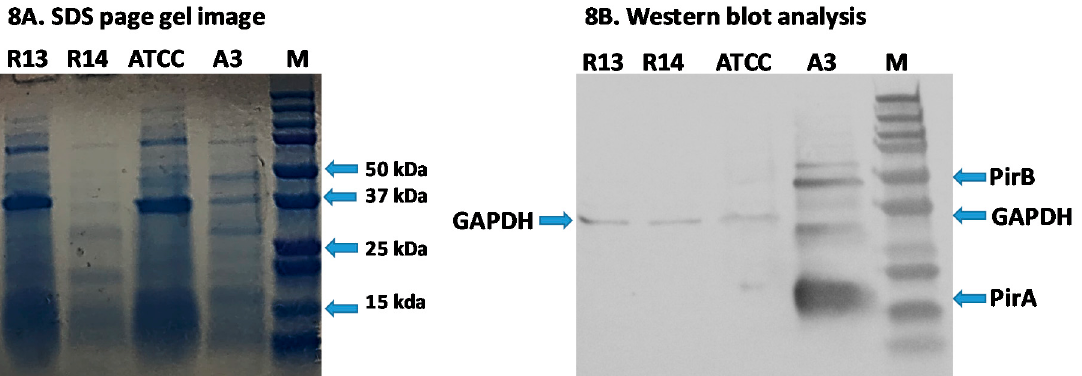
Figure 8. SDS-Page and Western blot analyses of proteins extracted from Vibrio parahaemolyticus R13, R14, ATCC and A3 strains. ( A ) SDS-Page gel image. ( B ) Western blot analysis. For each bacterial isolate, three micrograms of total protein were loaded into each well. Monoclonal antibodies against GAPDH (loading control), PirA, and PirB were used to detect corresponding proteins. Lane 1, V. parahaemolyticus R13 strain; lane 2, V. parahaemolyticus R14 strain; lane 3 V. parahaemolyticus ATCC strain; lane 4, V. parahaemolyticus A3 strain; lane M, 250kD protein ladder. The location of PirB (~50 kDa), GADPH (~37 and ~ 35 kDa) and PirA (~17kDa) proteins are indicated in the Western blot analysis image.